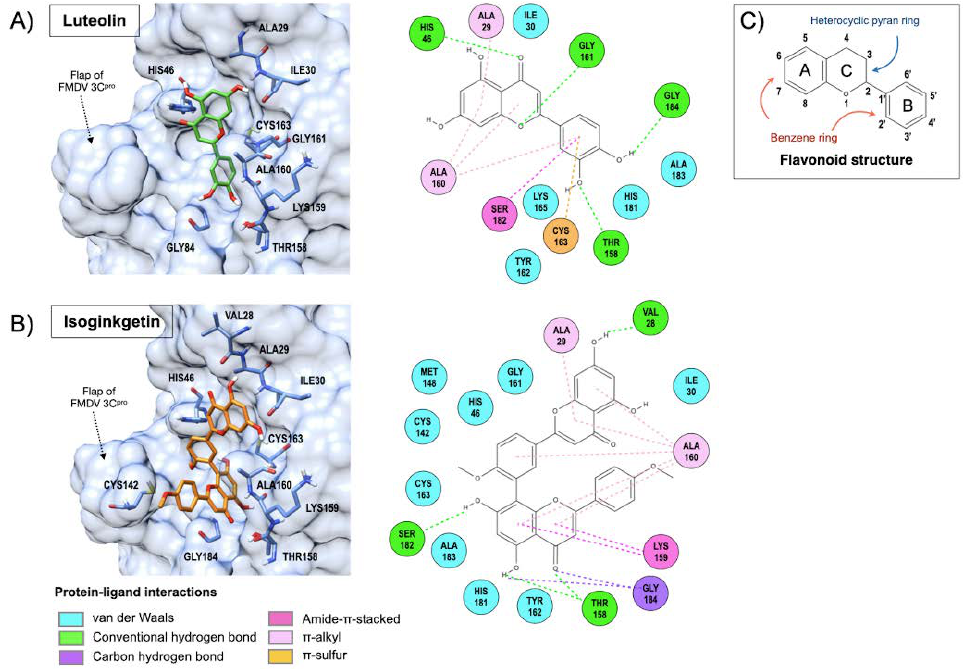
Figure 5. Molecular docking of FMDV 3C pro and protein–ligand interactions of luteolin ( A ) and isoginkgetin ( B ) with the binding pocket of FMDV 3C pro . The illustration colors for the protein-ligand bonds and interactions are presented at the bottom of Figure ( B ). The basic core structure of flavonoid contains two benzene rings (A and B rings) connected by a heterocyclic pyran ring (C ring) as shown in ( C ). Luteolin reacted to the catalytic residues, His46 and Cys163, whereas isoginkgetin showed van der Waals interaction with His46 and Cys163 as well as the Cys142 flap. The color circle of the amino acids indicates the interactive residues of the 3C pro and bond types as depicted at the bottom of the left panel.